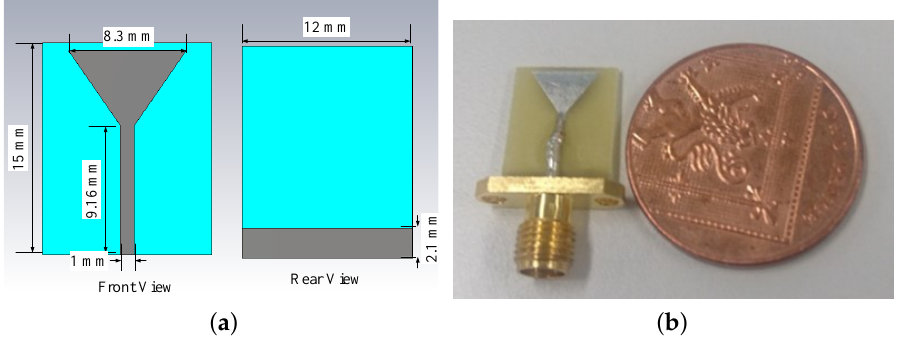
Figure 1. ( a ) Schematic of the proposed antenna modelled in CST Microwave Studio; ( b ) Photo of the fabricated antenna.